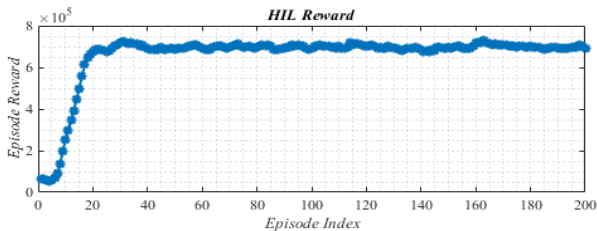
Figure 9. SIL and HIL rewards.